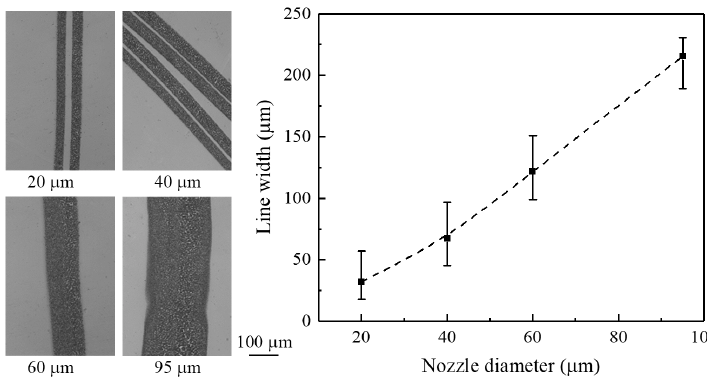
Figure 9. The effect of nozzle diameter on line width. The applied voltage is 1.5 kV, the nozzle-to-substrate distance is 0.5 mm, and the flow rate is 100 µ L/h.